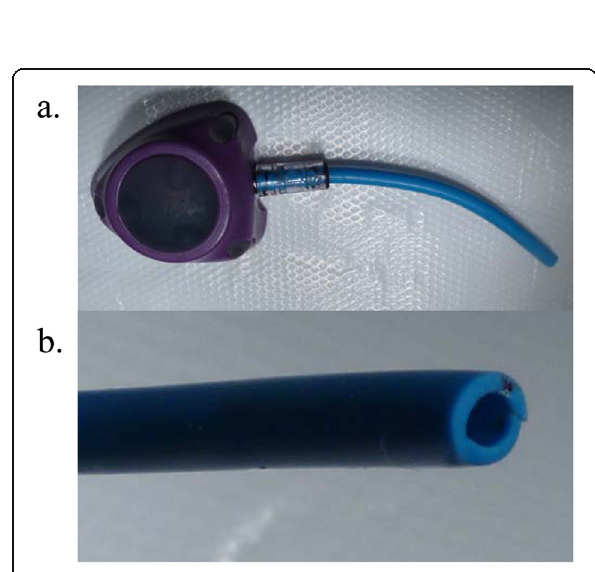
Fig. 3 Edges of the fractured catheter. a The vertical catheter fracture at a point 4 cm from the connector, which was circumferentially aligned. b The edges of the fractured catheter were rounded and polished. Upon removal of the TIVAP septum, the cross-section of the fracture was dull, with an overall elliptical